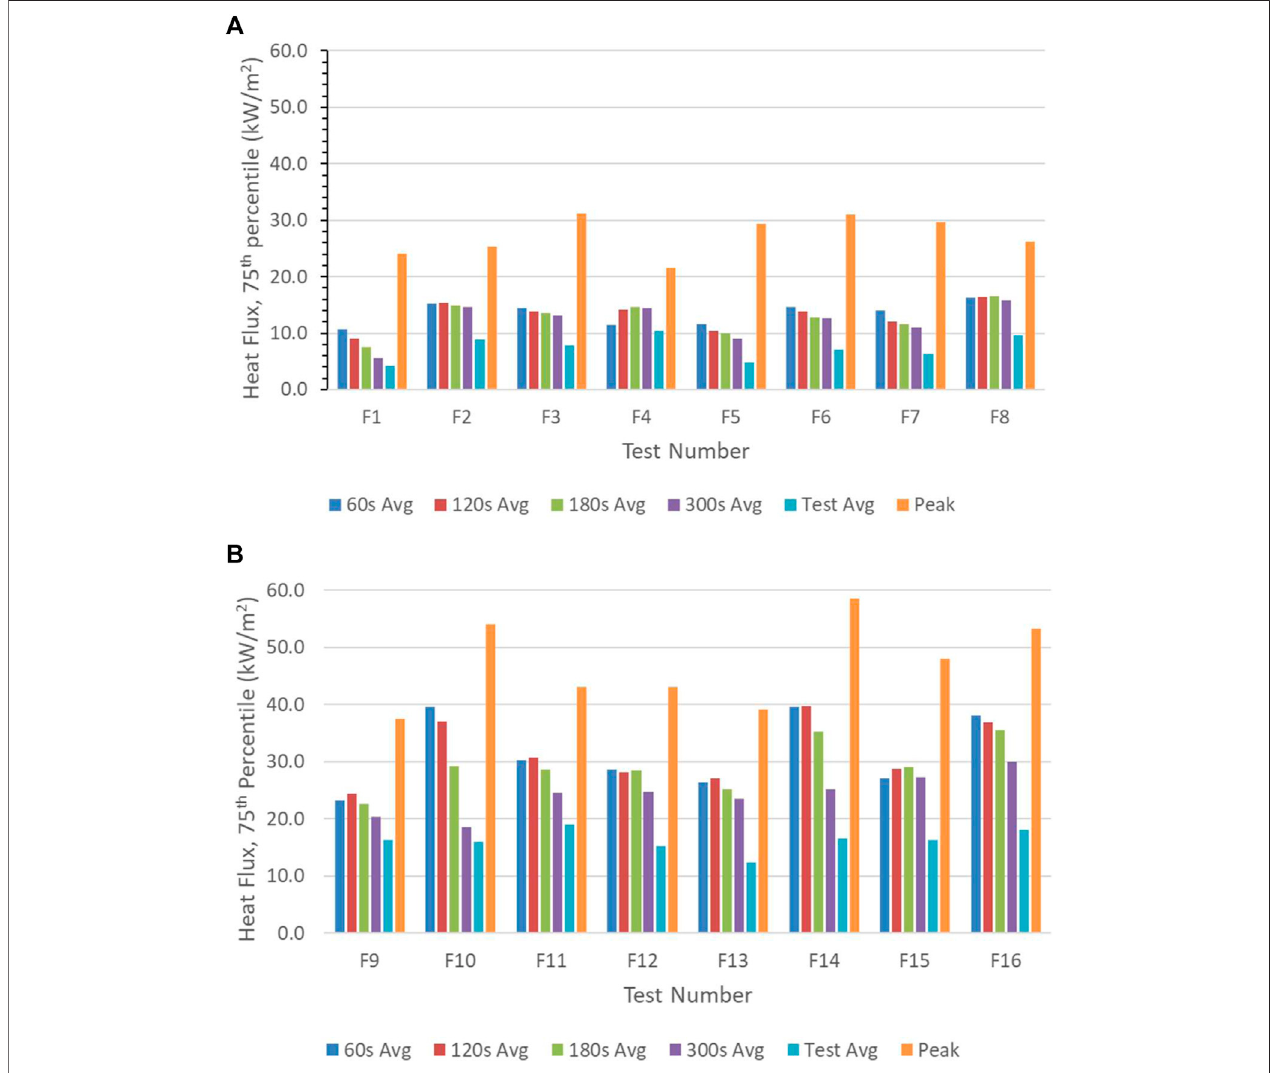
FIGURE 6 | The 75th percentile heat fl ux over different average times and for the peak with (A) a wind speed of 0 m/s and (B) with a 2.0 m/s wind speed for all the full-factorial tests.